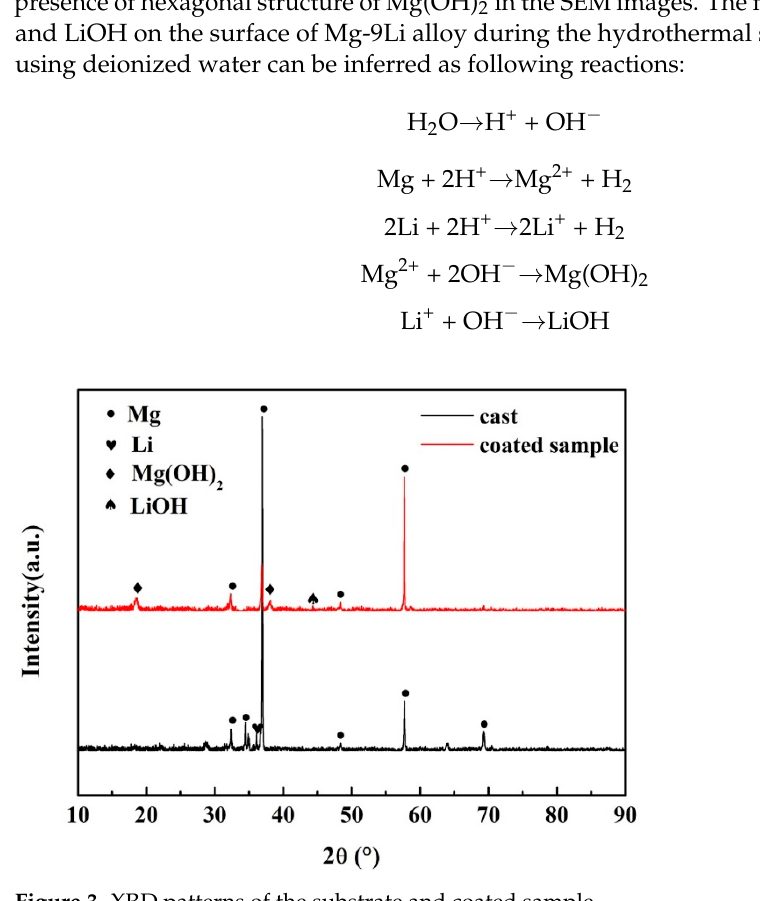
Figure 3. XRD patterns of the substrate and coated sample.